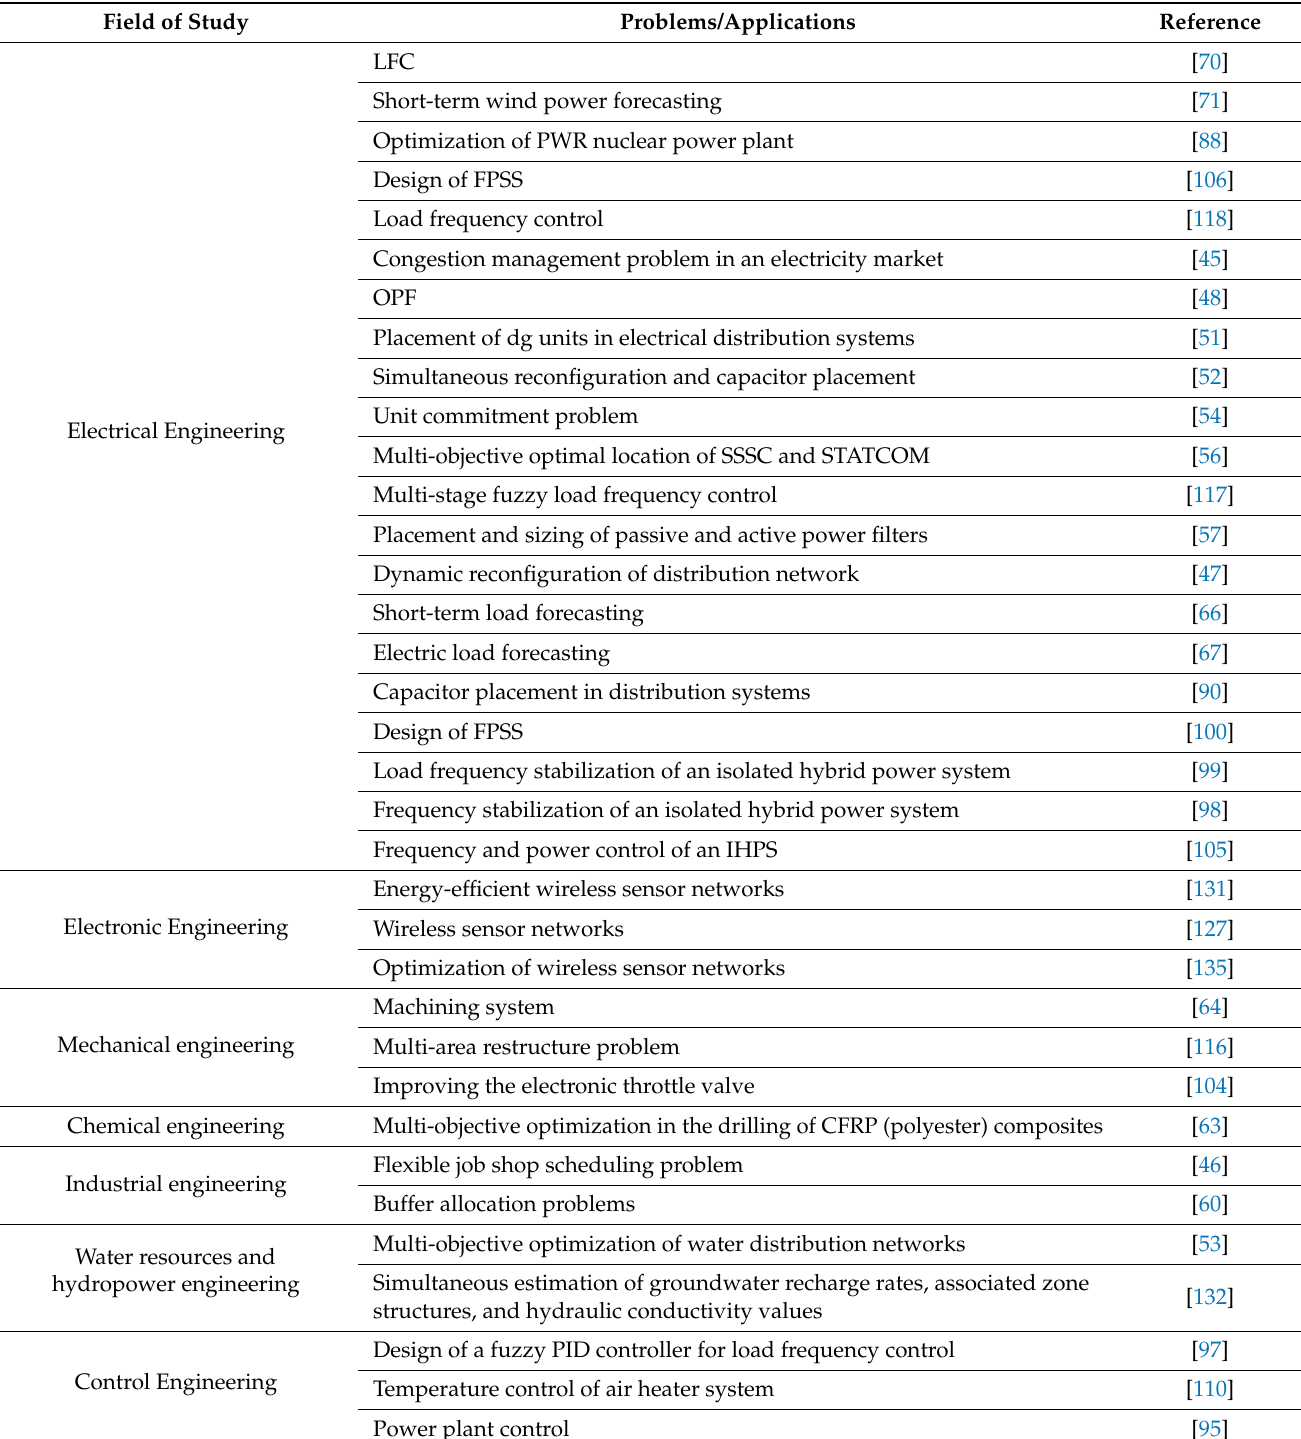
Table 9. The application of HS and FL in various fields of